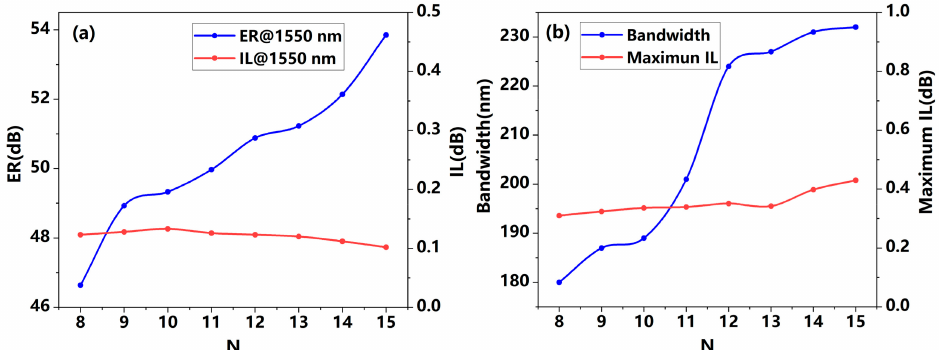
Figure 7. ( a ) The extinction ratio and insertion loss as a function of grating period numbers at 1550 nm; ( b ) maximum insertion loss and operating bandwidth as a function of grating period numbers.